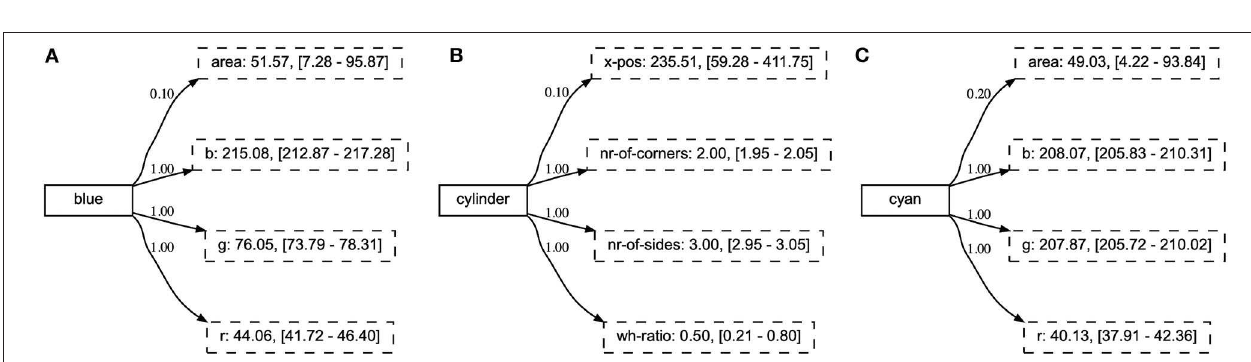
FIGURE 12 | The final representation of concepts introduced in various phases of the experiment. The concept BLUE was introduced in phase 1 (A) , CYLINDER in phase 3 (B) , and CYAN in phase 5 (C)